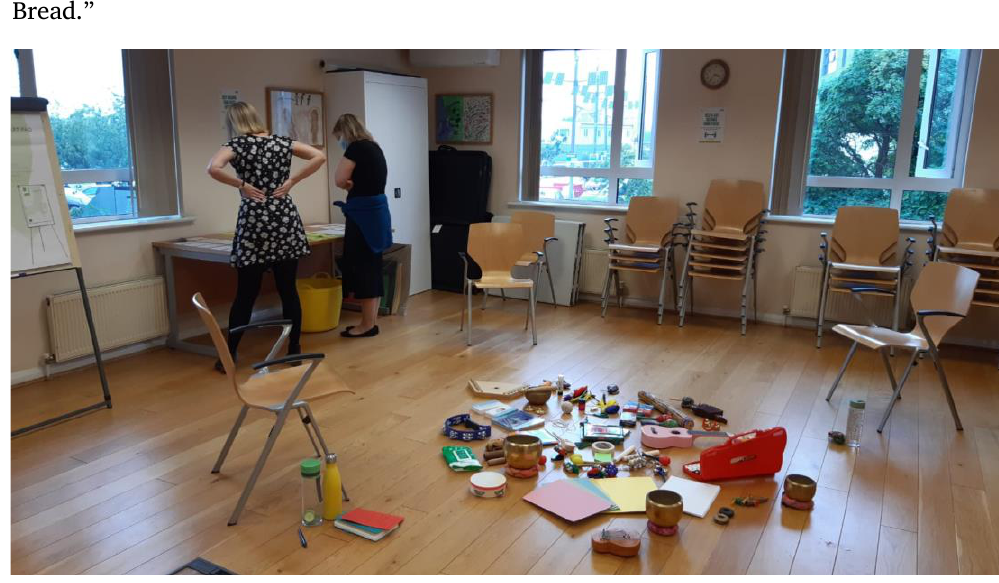
Figure 5. Table-top tour by Catherine and